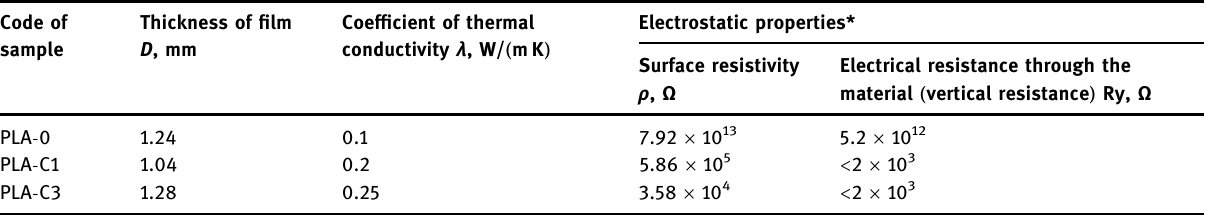
Table 8: Thermal conductivity and electrostatic properties of fi lms from shell material ( PLA and PLA composites with di ff erent amounts of MWCNT )